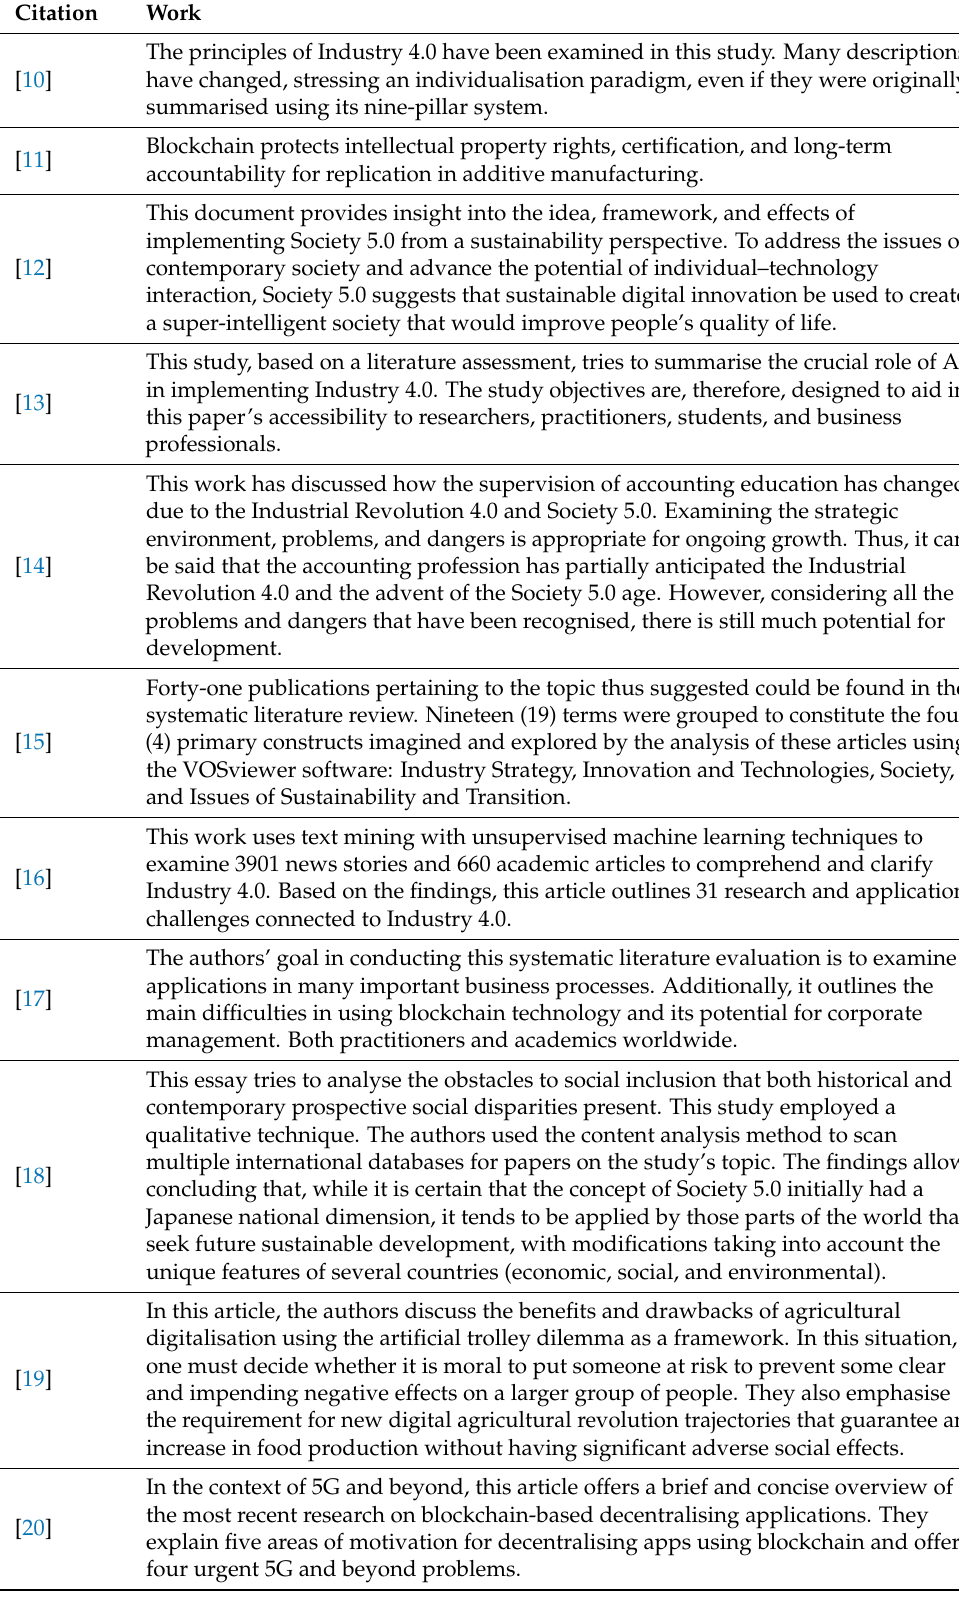
Table 1. Comparison of Current Works in the